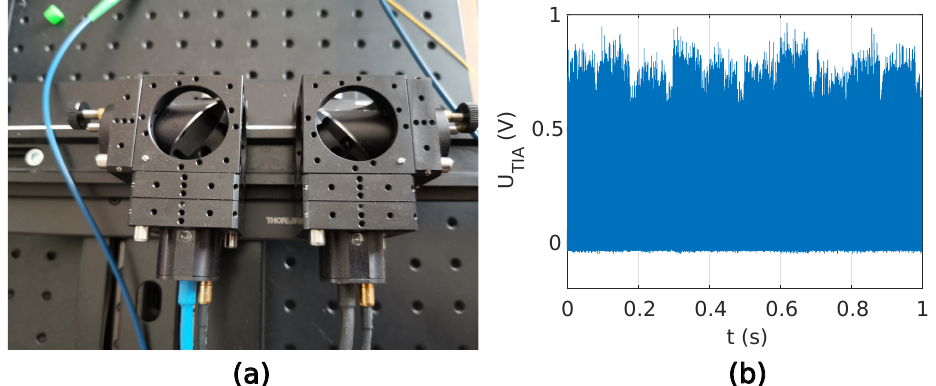
Figure 10. Experiment with unobstructed THz beam path: ( a ) PCAs positioning, ( b ) section of the measured TIA’s output